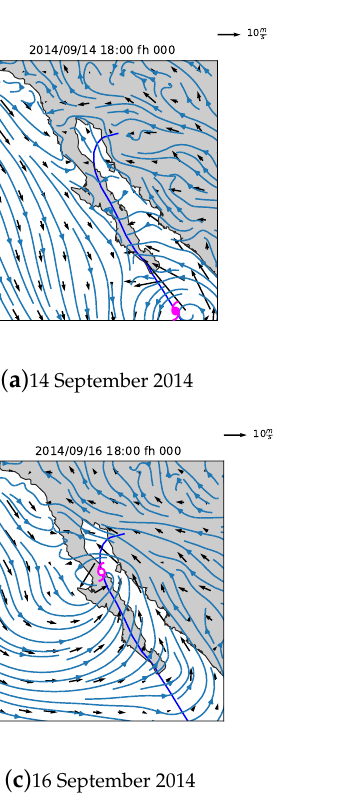
Figure 2. Wind field during Hurricane Odile. The HURDAT trajectory (see https://www.aoml.noaa. gov/hrd/data_sub/hurdat.html) is shown as a dark blue line, wind vectors as black quivers and streamlines as light blue lines. All times in UTC. The geographical position of Odile is